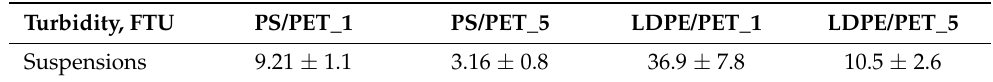
Figure 14. Photos of the solutions LDPE/PET: ( A ) LDPE/PET_1: (a) solvent, (b) suspensions; ( B ) LDPE/PET_5: (a) solvent, (b) suspension. Table 14. Degree of turbidity of suspensions.